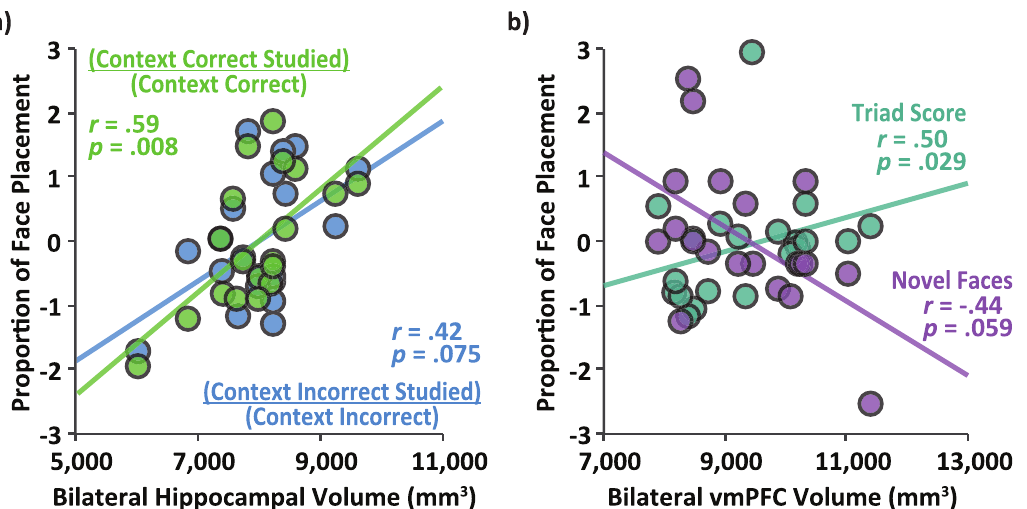
Fig 9. Behavior and volumetric relationships. ( a) The correlation between bilateral hippocampal volume and preference for placing the face in the studied room as a proportion of all face placements to context-correct (green) and context-incorrect (blue) sides of the building. (b) The correlation between bilateral ventromedial prefrontal cortex volume and both correct novel face placements (purple) and Triad Scores (studied room placements on the context-incorrect side of the building divided by studied room placements to the context-correct side of the building; teal). All behavioral data were z -scored for presentation